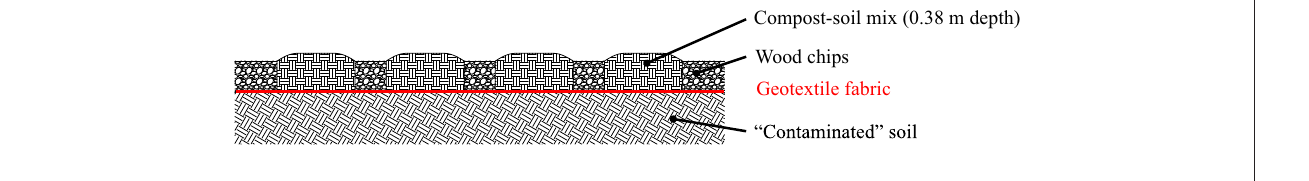
FIGURE 1 | Urban cap-and-fill